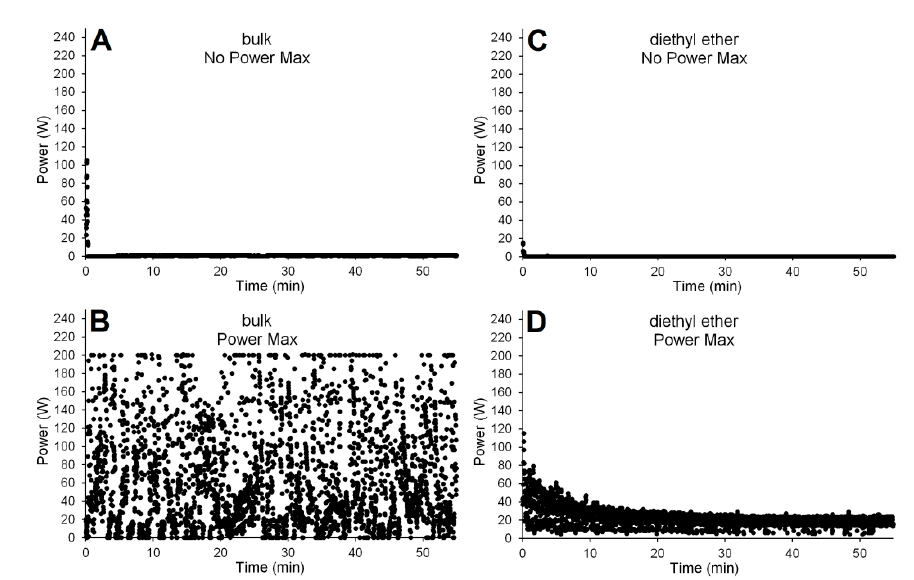
Figure 5. Microwave energy erogation plots over time for ( A ) bulk/no Power Max; ( B ) bulk/Power Max; ( C ) diethyl ether/no Power Max and ( D ) diethyl ether/Power Max reactions between DMS and BDO. For the Power Max function, the maximum reachable power was set to 200 W, temperature was kept constant via a continuous compressed air flow.